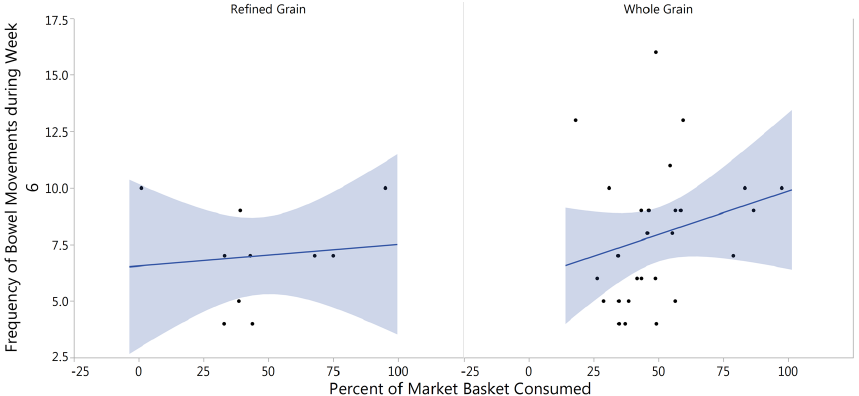
Figure 5. Percent of market basket consumed related to bowel movement frequency. The association between bowel movement frequency and percent of market basket consumed for refined grain consumers ( left panel) and whole grain consumers ( right panel) as determined by logistical regression and Wilcoxon Rank Sum testing. The refined grain treatment represents data from ten subjects; the whole grain treatment represents data from 27 subjects. There is a significant positive association with whole grain consumption ( p = 0.046), but not with refined grain consumption ( p = 0.407).